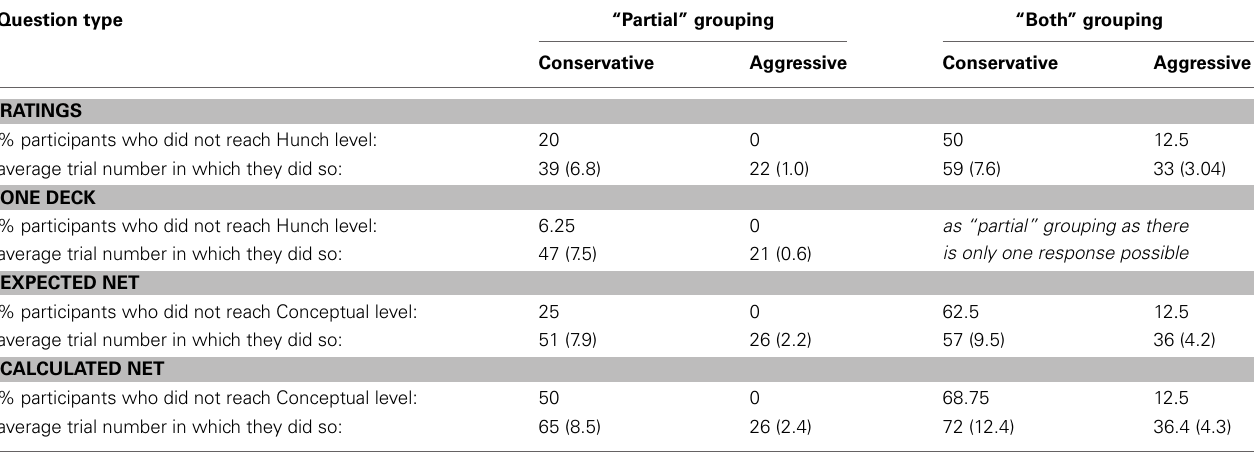
Table 2 | Knowledge assessment for Specific question group using “partial” grouping (either deck with the highest net value at the time of questioning received the best score on each measure) or “both” grouping (both decks with the highest net value at the time of questioning received the best scores on each